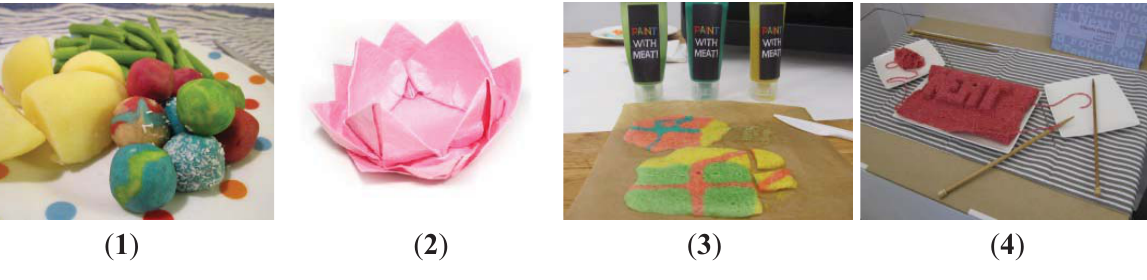
Figure 2. Eindhoven student designs of cultured